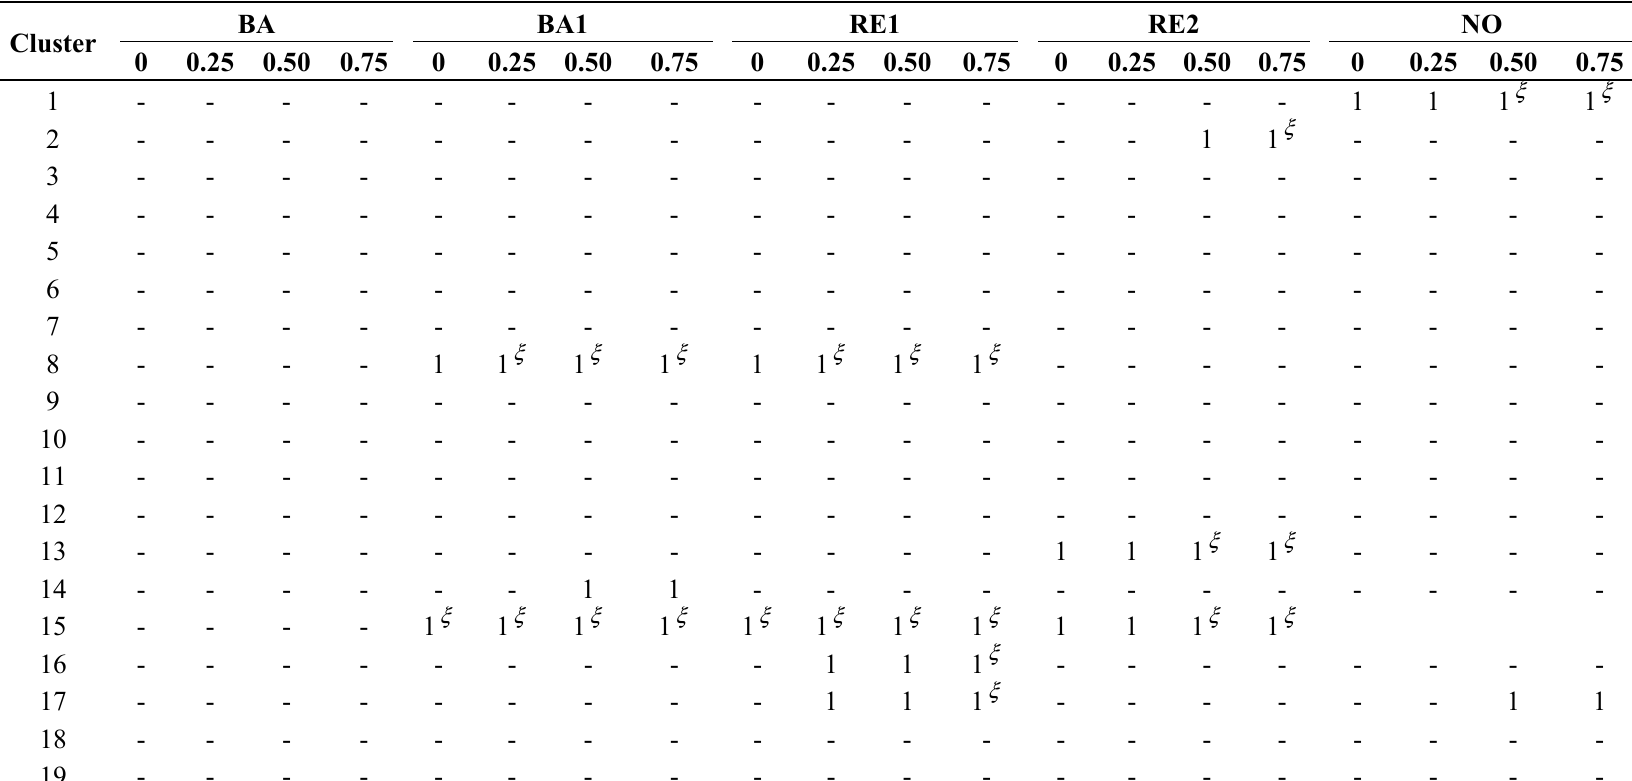
Table 6. Diffusion of biogas plants in case of alternative co-funding measures (Number of